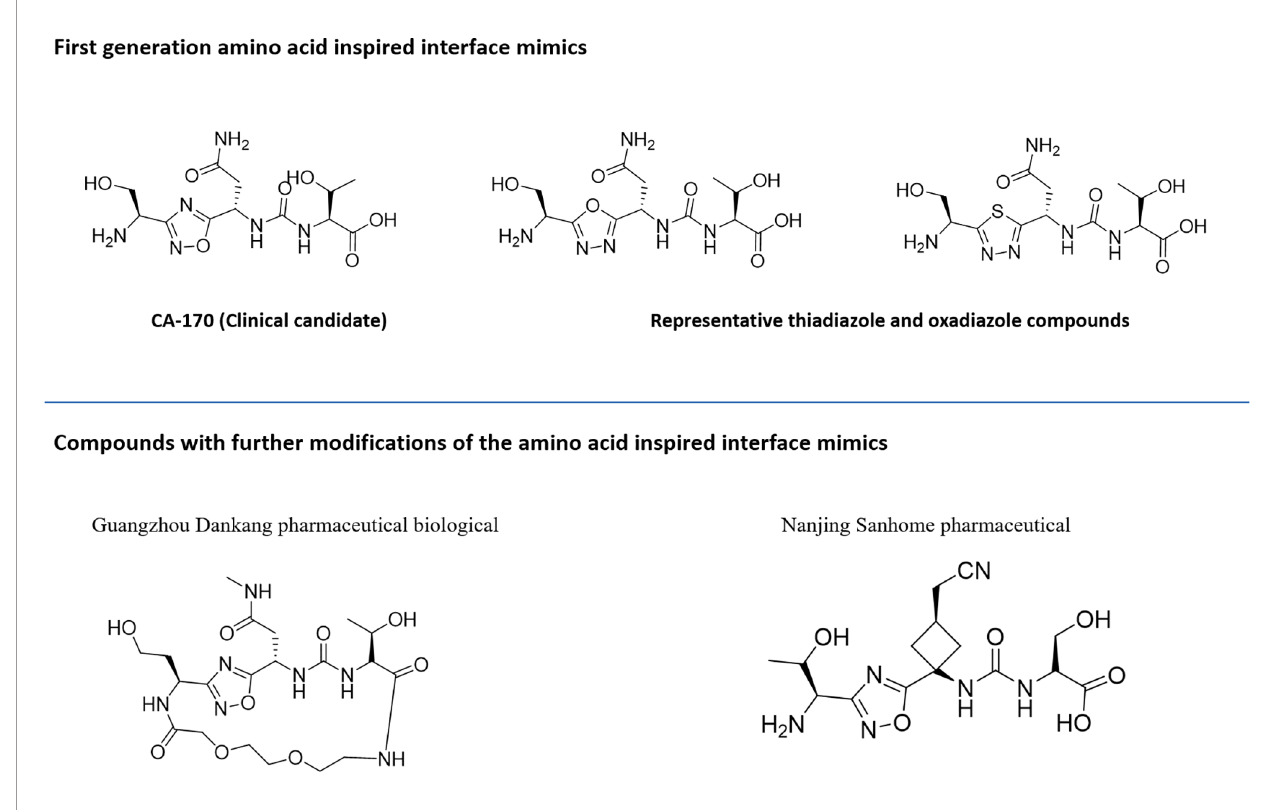
FIGURE 5 | Representative structures of amino-acid-inspired interface mimics targeting